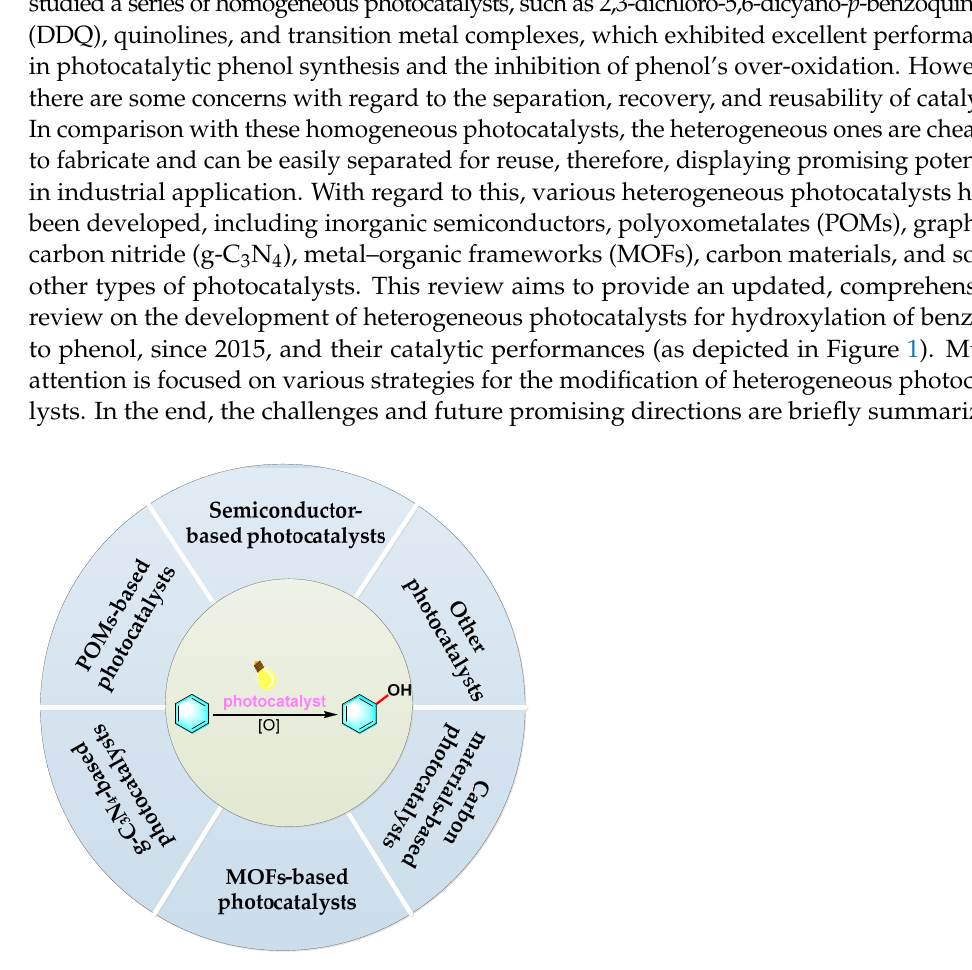
Figure 1. Various types of heterogeneous photocatalysts developed for hydroxylation of benzene to